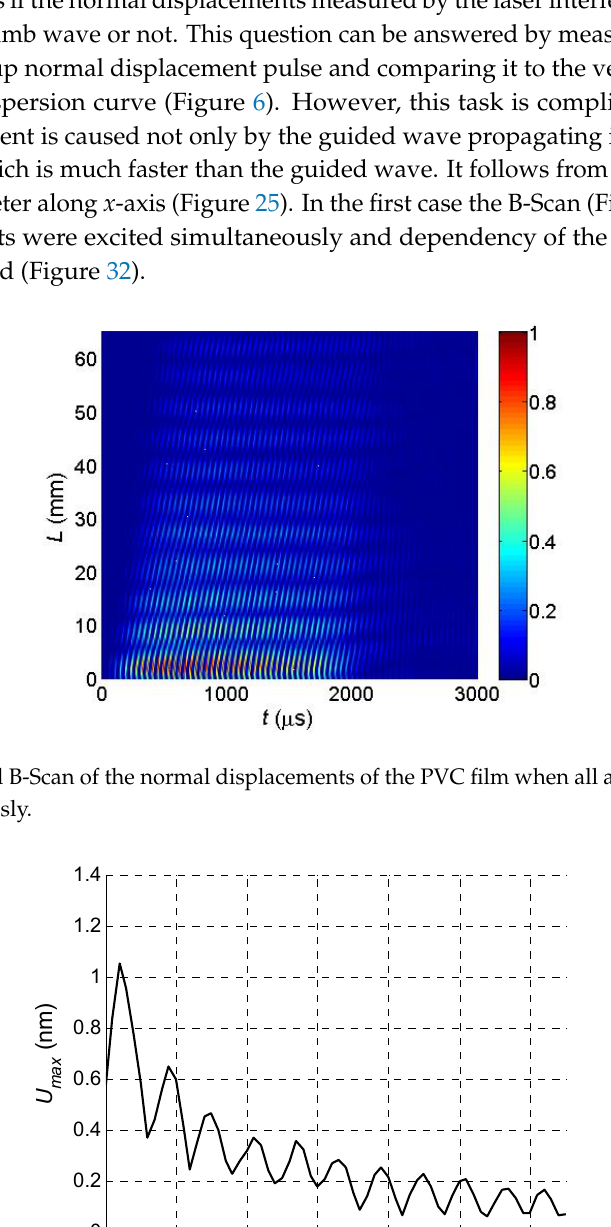
Figure 33. Measured B-Scan of the normal displacements of the PVC film when the optimised time delays between array elements were used.